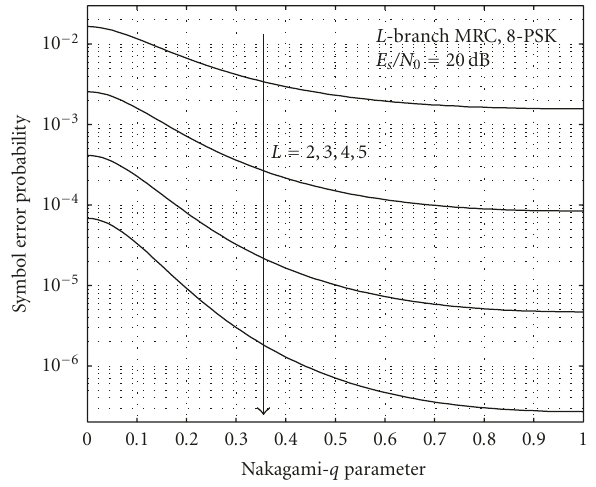
Figure 3: Symbol error probability of 8-PSK with L -branch MRC in SIMO Nakagami- q fading channels as a function of the Nakagami- q parameter. L = 2,3,4,5 and E s /N 0 = 20 dB.